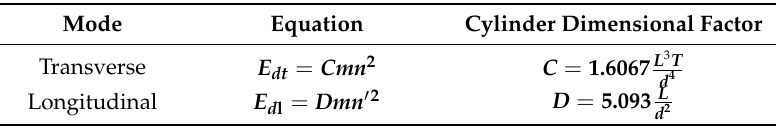
Table 5. Governing equations for dynamic elastic